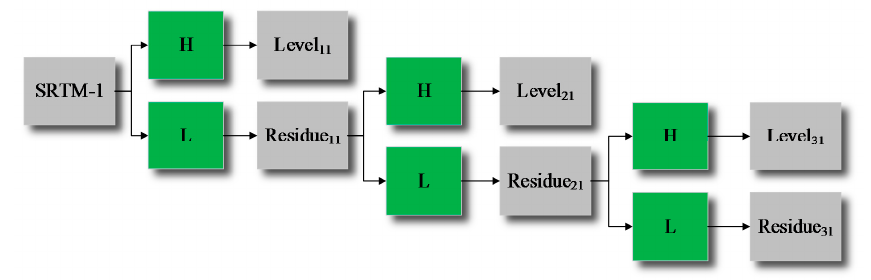
Figure 4. Schematic of three level wavelet decomposition of the SRTM-1.